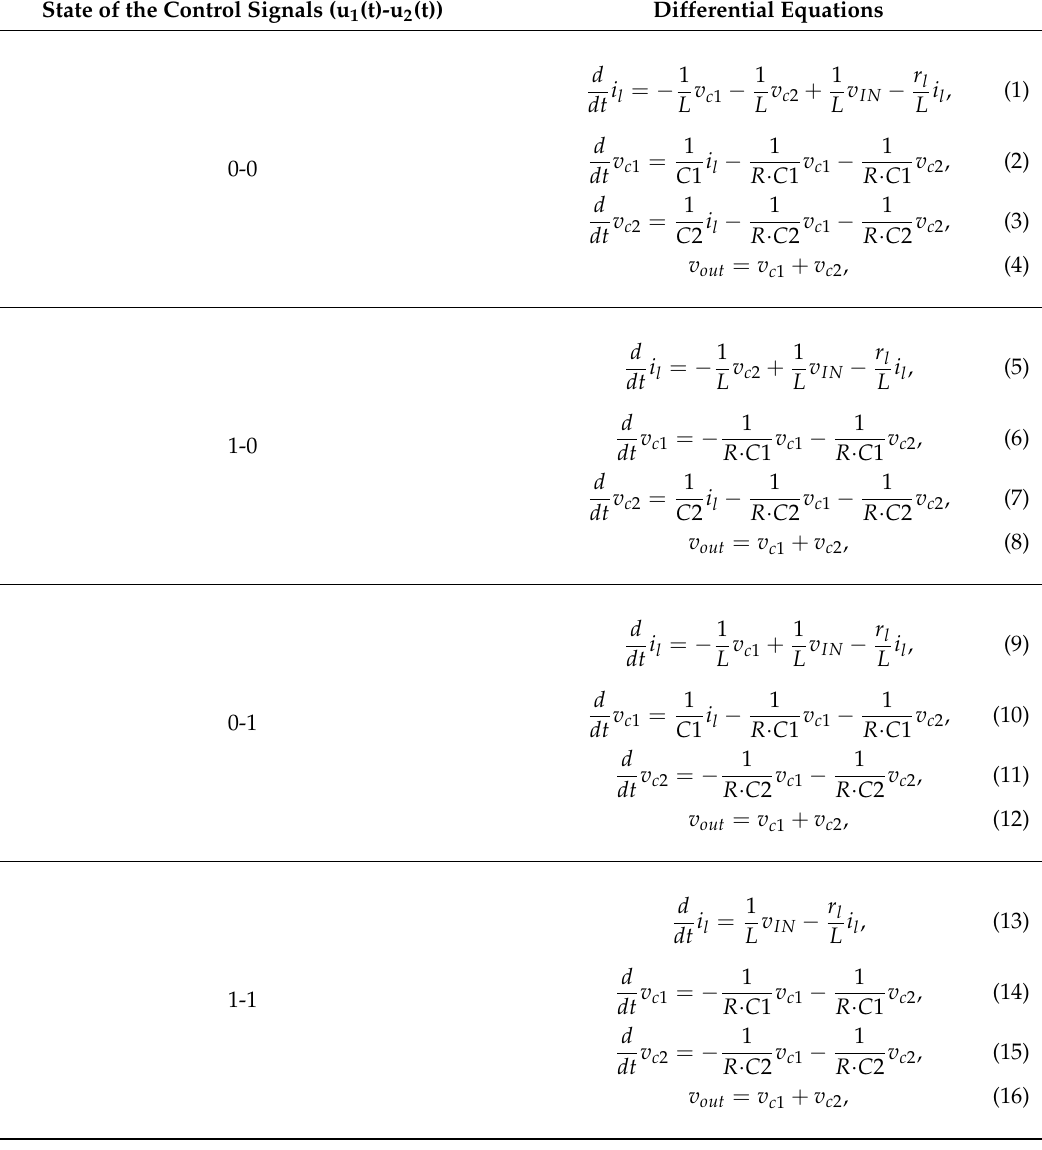
Table 1. Differential equations for each control signals sequence of TLBDC working in CCM. State of the Control Signals (u 1 (t)-u 2